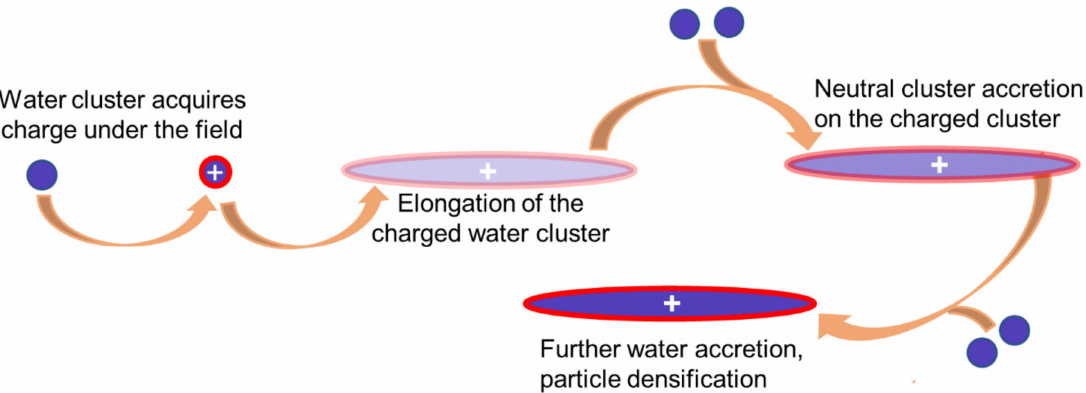
Figure 1. A Non-classical mechanism for ice particle formation from water vapor under the influence of an electric potential